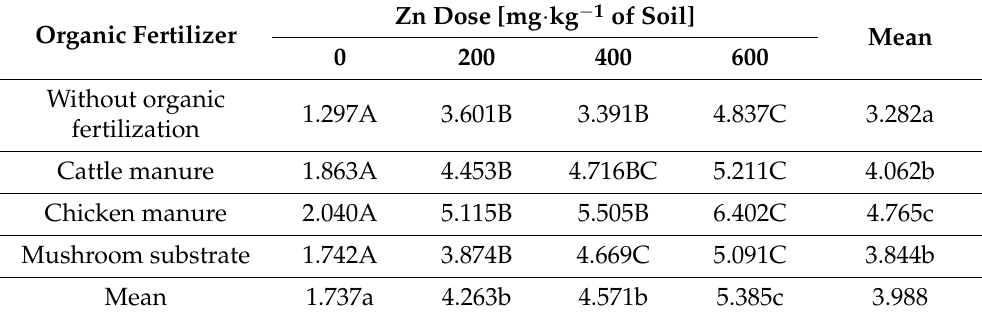
Table 7. Total Zn uptake by cocksfoot at the sum for three years (mg Zn · pot − 1 ). Organic Fertilizer